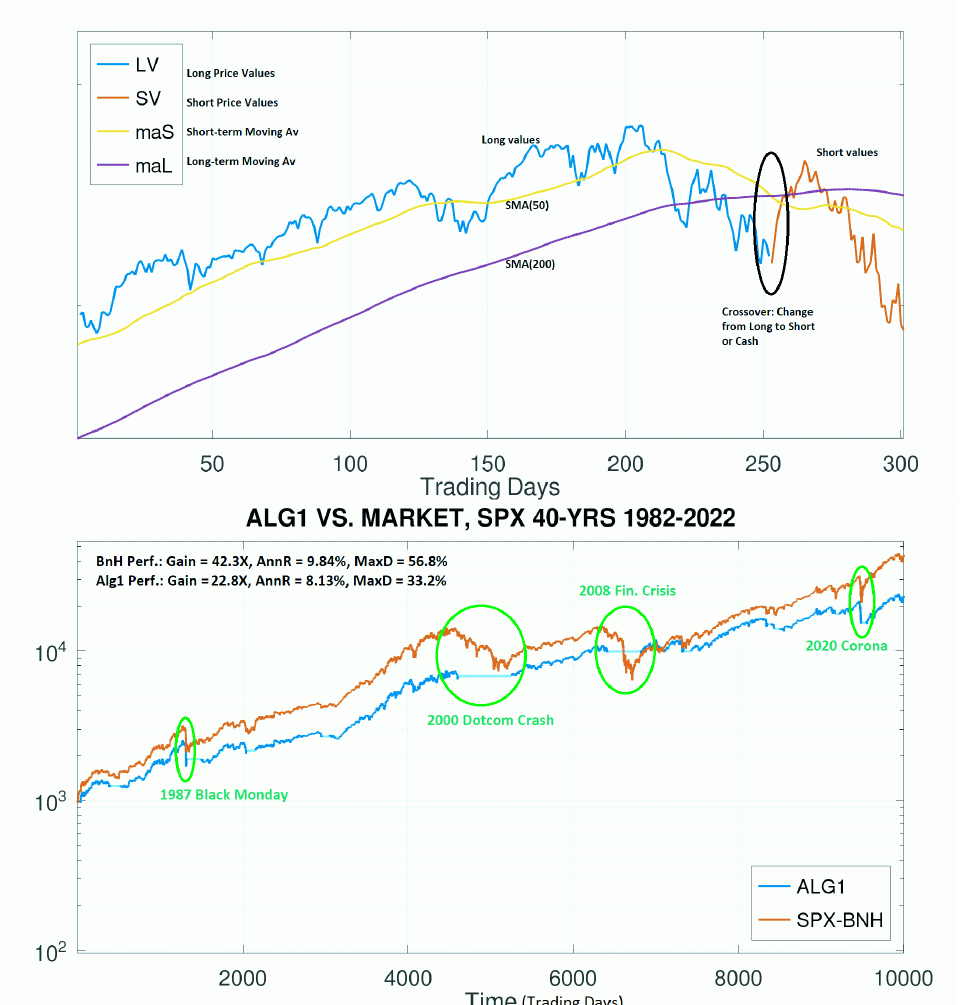
Figure 2. ( top ) Example of Algorithm 1 in action, with a segment of the S&P500 data, showing key elements. When SMA(50) crosses below the SMA(200), the method switches from long to short or cash, and vice versa. ( bottom ) Performance of Alg1 vs. BnH, on SPX, 1982–2022. Alg1 underperforms simple BnH, but it reduces drawdowns. That in itself may be a benefit for small